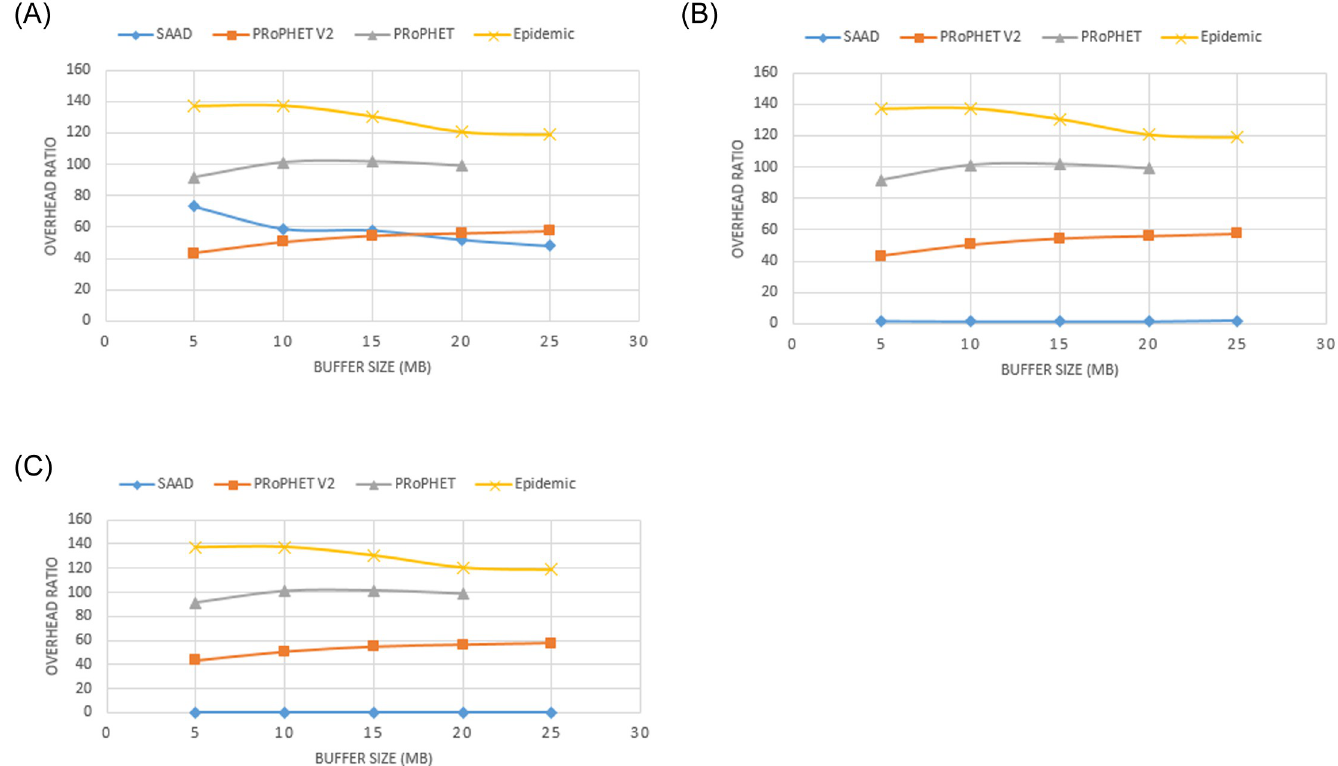
Fig 6. A. Overhead Ratio with different buffer capacity and DC (threshold = 0). B. Overhead Ratio with different buffer capacity and DC (threshold = 2). C. Overhead Ratio with varying buffer size and DC (threshold = 4).